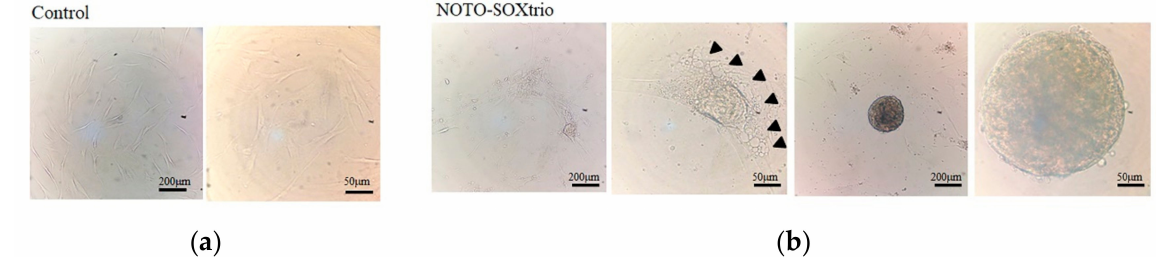
Figure 4. Cultures of the NOTO-SOXtrio group include vacuolated cells and CFU-S. The NOTO- SOXtrio group was cultured with alginate beads for 4 weeks: ( a ) control group; ( b ) NOTO- SOXtrio group. Arrowheads indicate intracellular vacuoles, and numerous intracellular vesicles were observed.